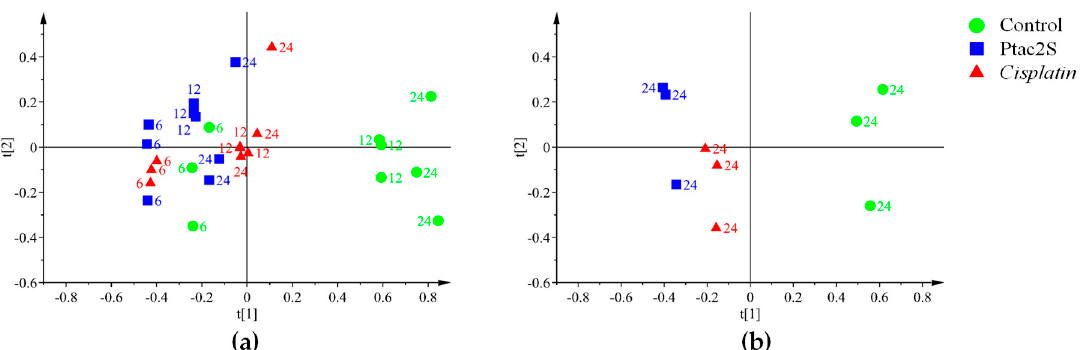
Figure 9. PCA score scatter plot of the 600 MHz 1 H-CPMG-NMR spectra (Pareto scaled) obtained from recovered culture media of Ptac2S and cisplatin treated SKOV-3 cells in comparison with the untreated control samples. The indicated labels are referred to the culture times. ( a ) PCA t[1]/t[2] (four components give R 2 X = 0.969, Q 2 = 0.936). ( b ) PCA t[1]/t[2] (two components give R 2 X = 0.857, Q 2 = 0.678).